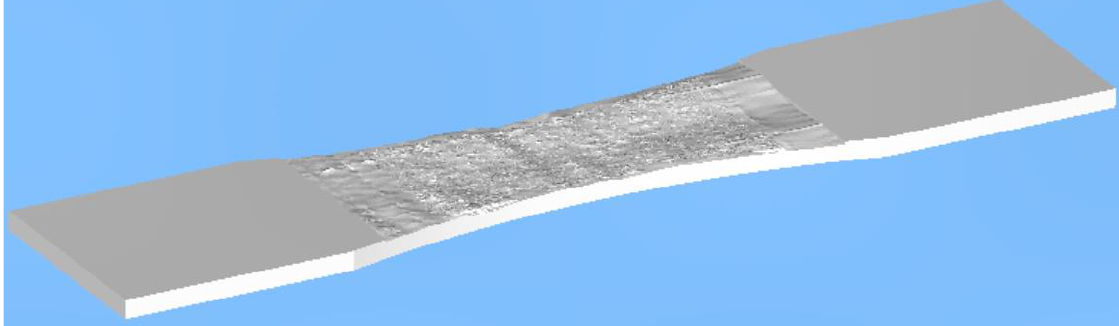
Figure 6. A typical CAD model with the surface roughness as measured in [1]. The in-plane dimensions are as shown in Figure 3.